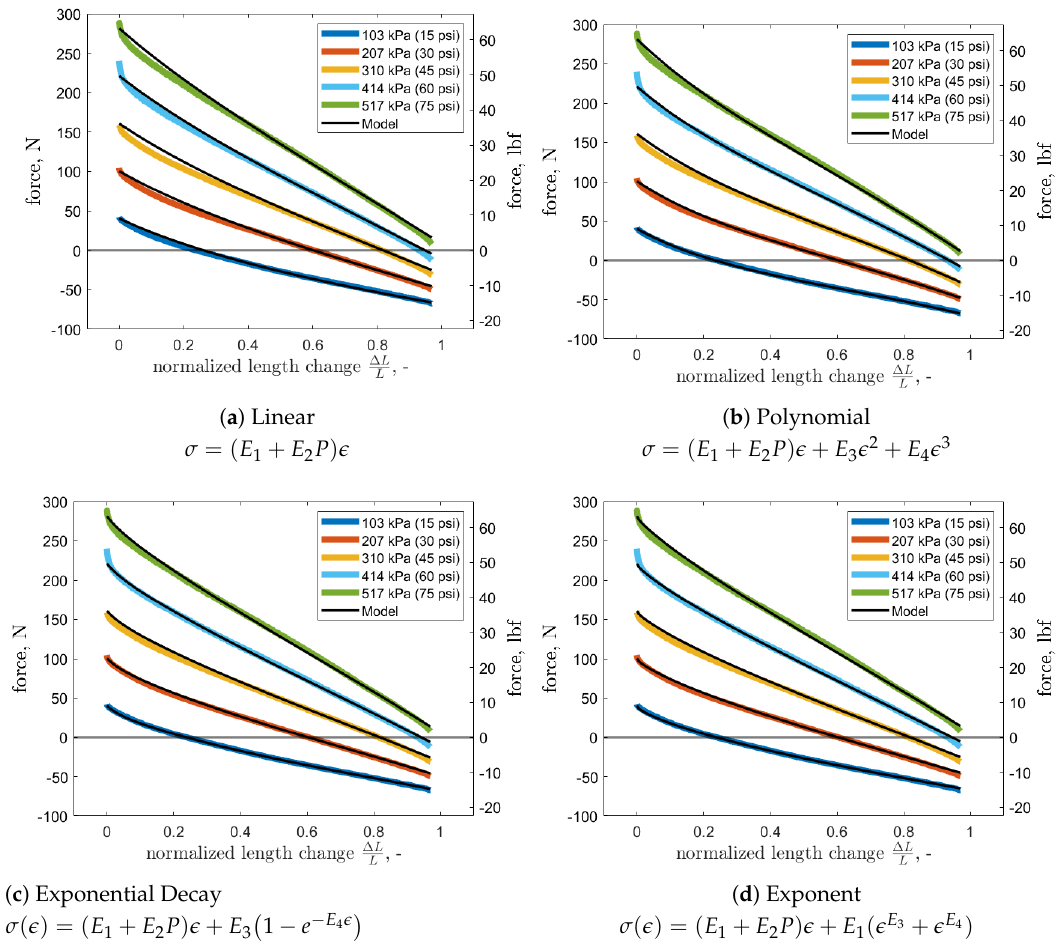
Figure 10. The quasi-static axial force responses of FAM2 extensile fluidic muscles to varying strain for incrementally increasing internal pressure. The axial force outputs of the force-balance model employing the studied stress functions are overlayed as black lines for comparison to experimental